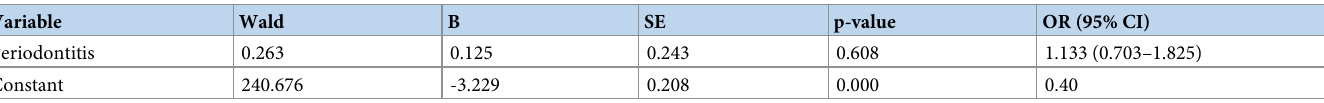
Table 4. Results from logistic regression analysis on periodontitis vs . prostate cancer. Beta and standard error, Walds chi-sqare and p-value, odds ratio and 95 percent confidence interval (CI). Variable Wald B SE Periodontitis Education